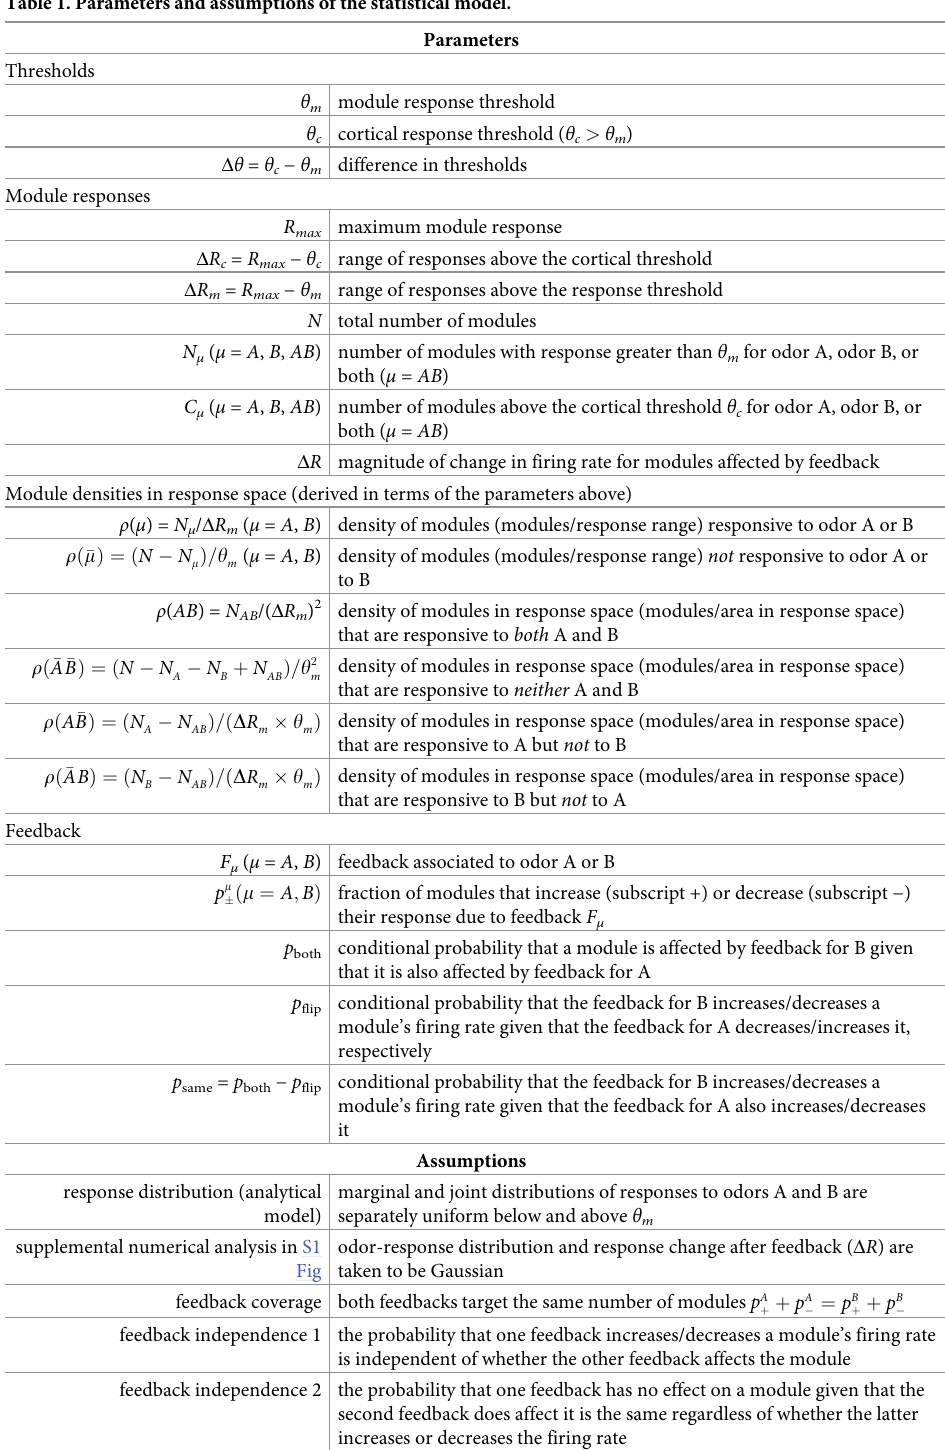
Table 1. Parameters and assumptions of the statistical